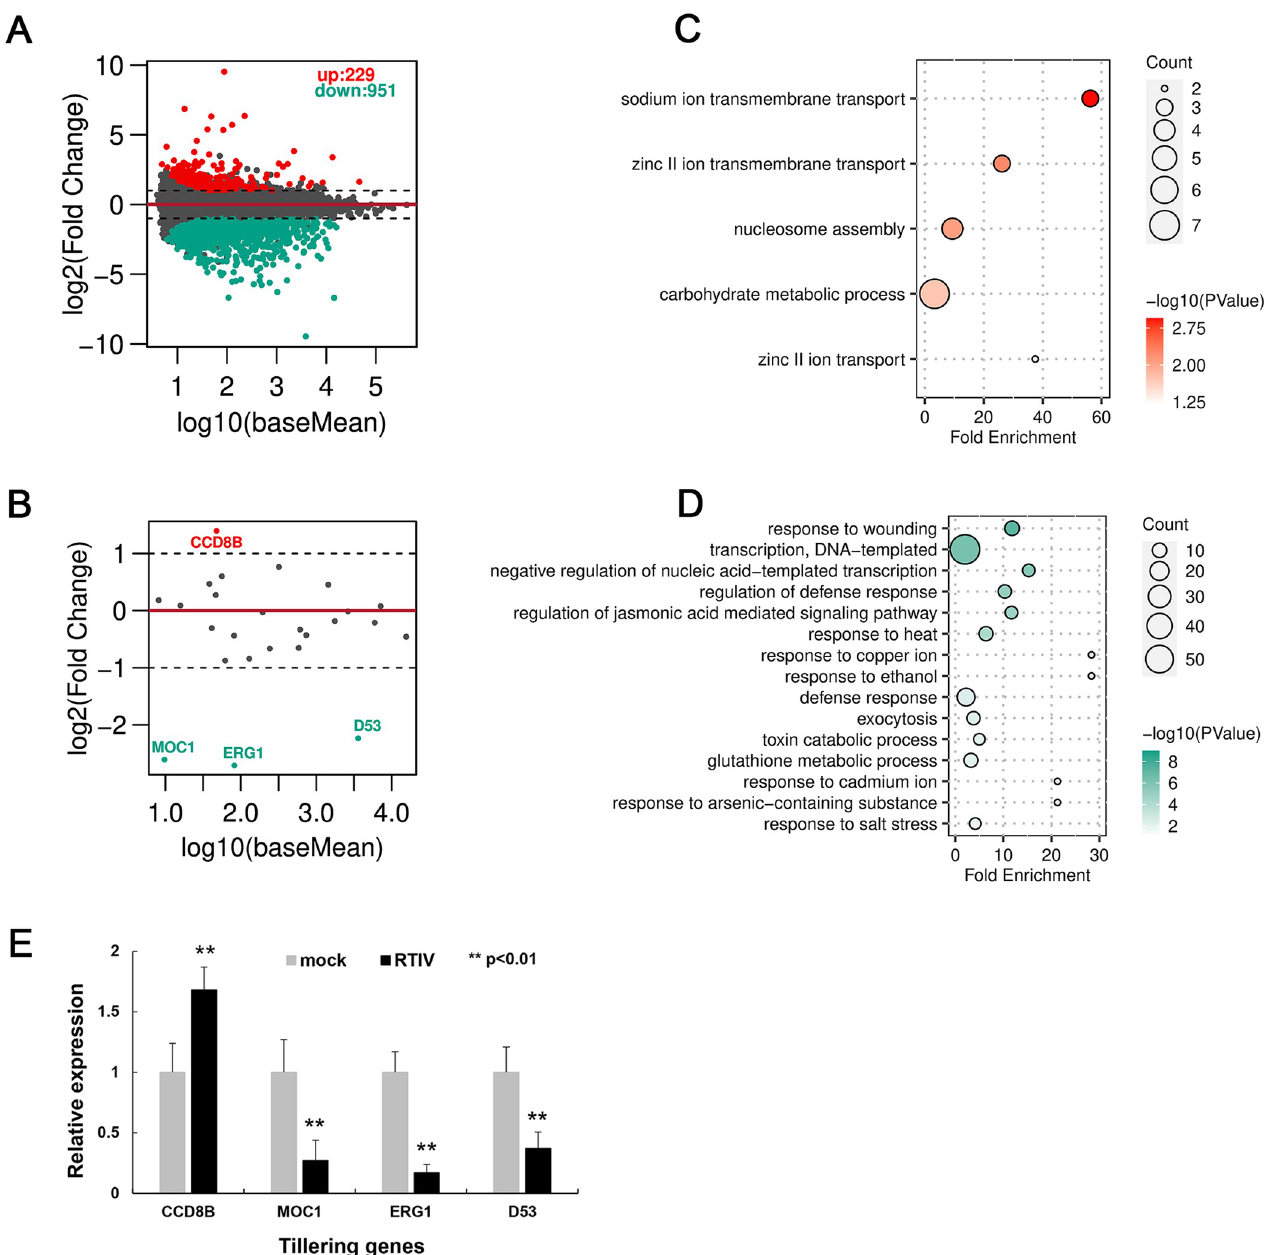
Fig 5. RTIV modulated defense responses and caused low-tillering disease in rice plants after spillover through vector aphid. (A) All genes of altered expression profile, log2 values are the fold change of gene expressions, baseMean are the gene reads of library standardization. (B) Tillering-related genes of altered expression profile. (C-D) KEGG pathway enrichment analysis of up-regulated genes (C) or down-regulated genes (D), count indicates the number of gene, log10 ( p value) indicates significance of difference. (E) RT-qPCR results shown transcript level of tiller genes in ago18 plants after RTIV infection compared to non-infected mock plants. Relative expression level of each gene was normalized to reference gene OsActin . Experiment was repeated 3 times, with 3 replicates for each reaction. ** p < 0.01 determined using the Student’s test and mean significant difference. Error bar: standard